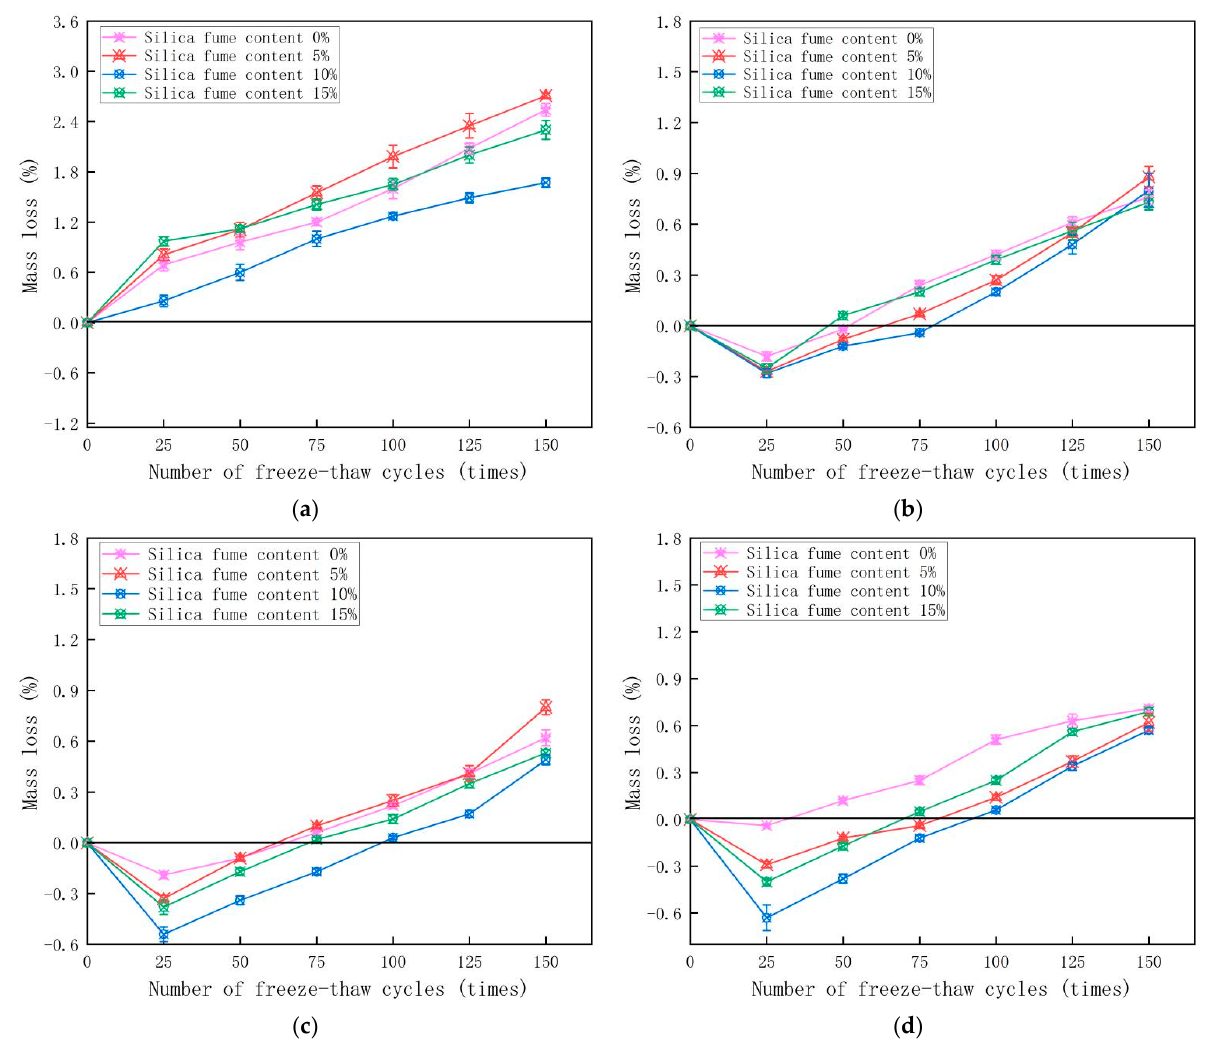
Figure 7. Mass loss rate: ( a ) Polyvinyl alcohol fiber content 0%, ( b ) Polyvinyl alcohol fiber content 0.5%, ( c ) Polyvinyl alcohol fiber content 1%, and ( d ) Polyvinyl alcohol fiber content 1.5%.